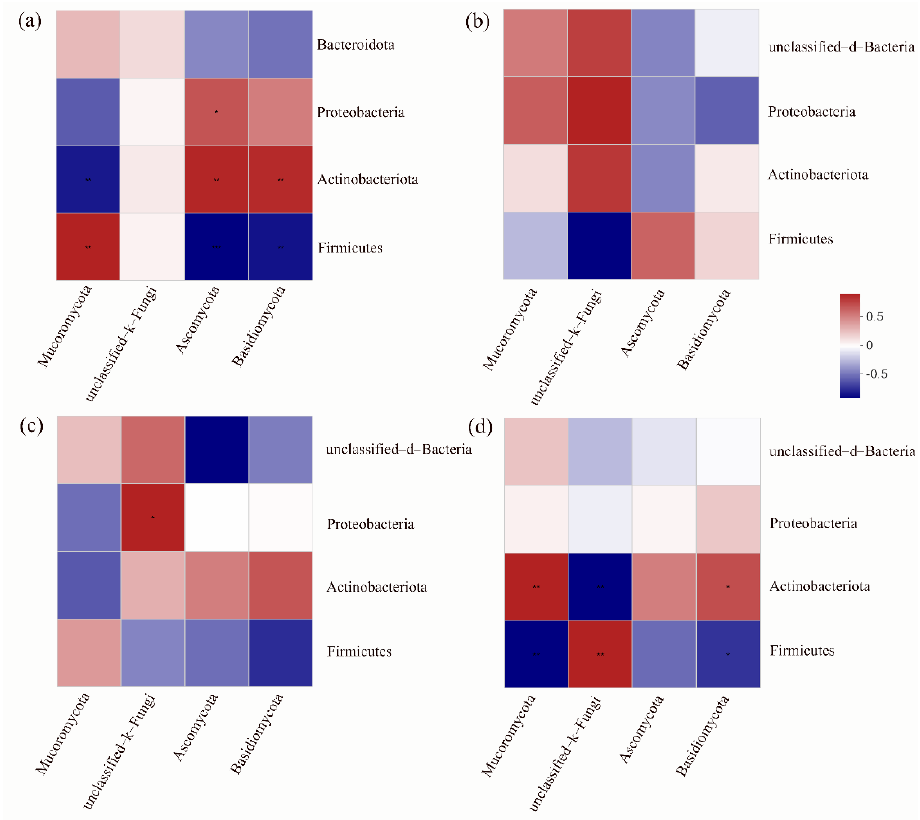
Figure 4. Correlation analysis of bacterial and fungal community compositions at phylum levels. ( a ) BP100; ( b ) BP90; ( c ) BP80; ( d ) BP65. * p < 0.05, ** p < 0.01.